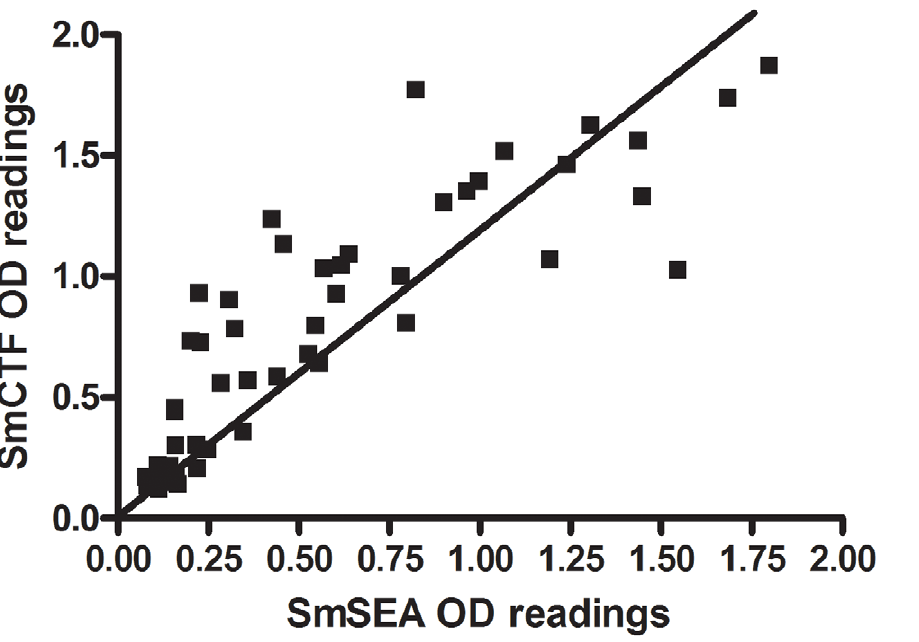
Figure 1. SPDRL: correlation between S.mansoni cercarial transformation fluid (SmCTF) and soluble egg antigen (SmSEA) in ELISA. Results for sera from suspected S. mansoni -infected patients (59 school pupils who attended a training course in the vicinity of the White Nile in Uganda).